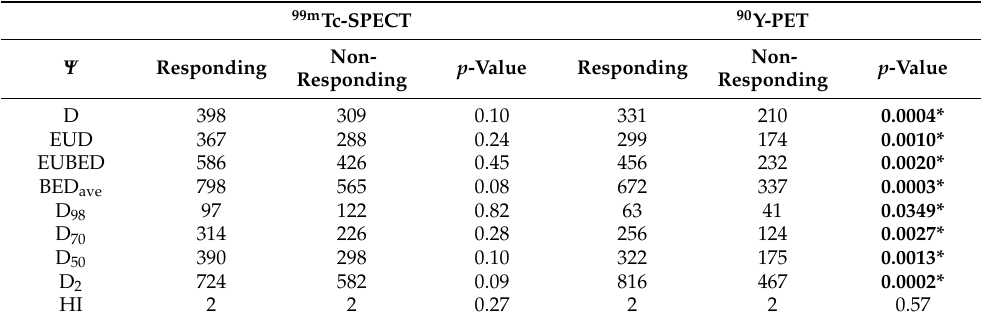
Table 6. Median Ψ values (in gray, except HI) and Mann–Whitney p -values for responding and non-responding lesions classified according to the densitometric criterion.